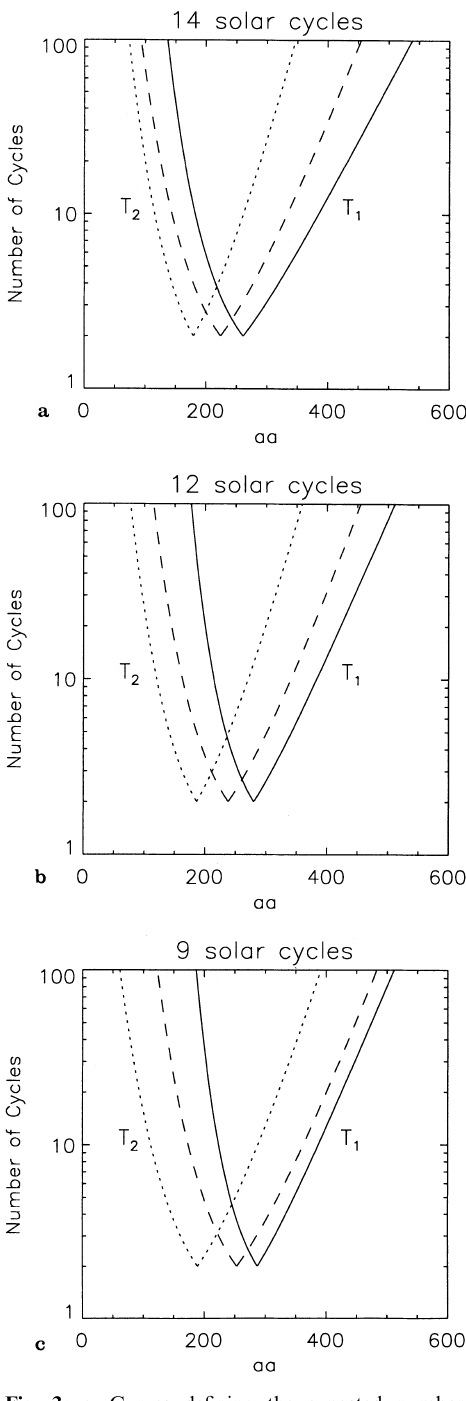
Fig. 3a–c. Curves defining the expected number of solar cycles required to find one cycle with an extreme value of aa equal to or greater than the abscissa ( T 1 branch) and to find one cycle with an extreme value of aa less than the abscissa ( T 2 branch) for the three largest (cid:133) m (cid:136) 1 ; 2 and 3 (cid:134) geomagnetic storms per solar cycle: a solar cycles 9–22, b solar cycles 11–22 and c solar cycles 11–19. The continuous , dashed and dotted curves refer to the first (cid:133) m (cid:136) 1 (cid:134) , second (cid:133) m (cid:136) 2 (cid:134) and third (cid:133) m (cid:136) 3 (cid:134) largest geomagnetic